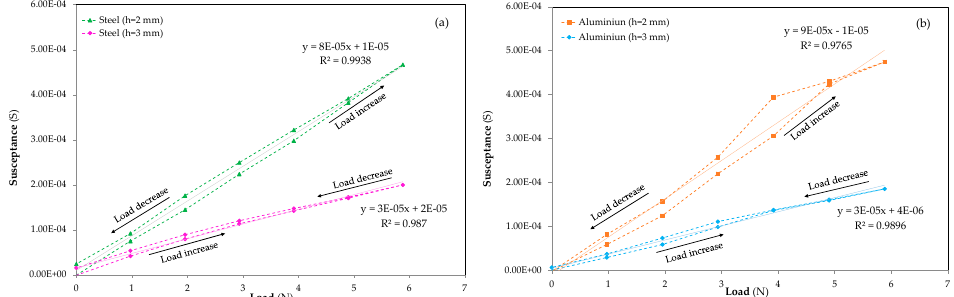
Figure 11. Susceptance evolution versus applied force: ( a ) steel smart structures where ( (cid:78) ) corresponds to h = 2 mm and ( • ) shows the h = 3 mm specimen results and ( b ) aluminium smart structures where ( (cid:4) ) represents h = 2 mm sample behavior and ( (cid:95) ) the h = 3 mm evolution .